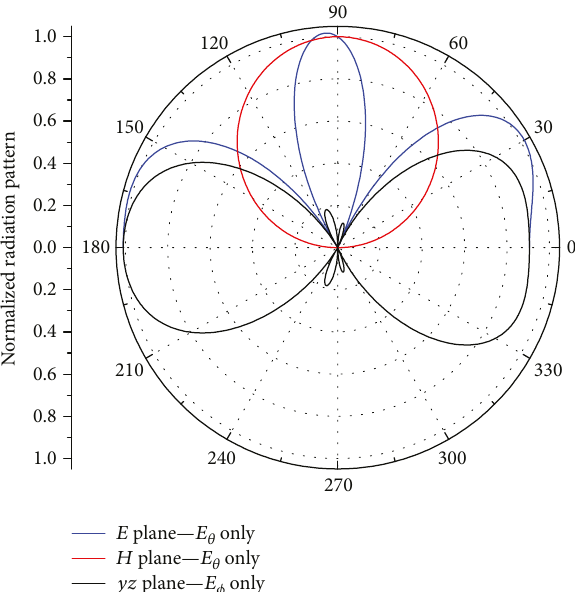
Figure 8: Normalized radiation pattern of the HB